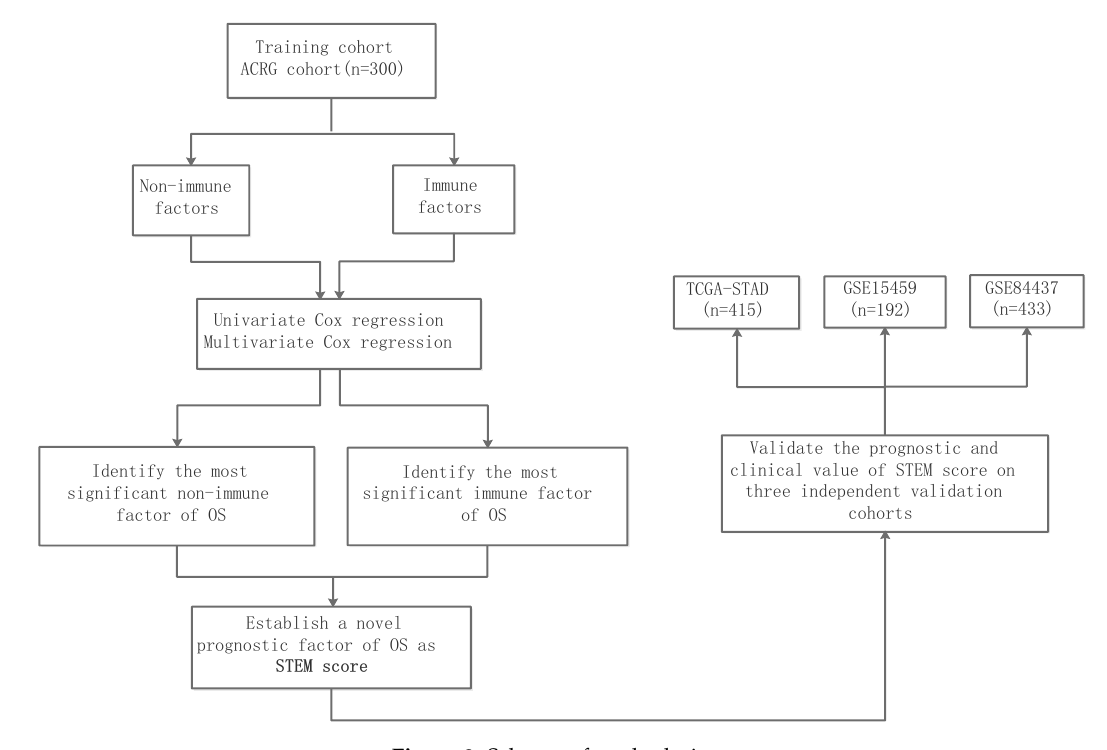
Figure 9. Schema of study design. Table 1. Univariate and multivariate results in Cox proportional hazards analysis of non-immune factors in the training cohort. The p value was derived from the Cox regression model; FDR adjusted, multiple comparison adjusted p values calculated by false discovery rate approach; HR, hazard ratio; CI, confidence interval.